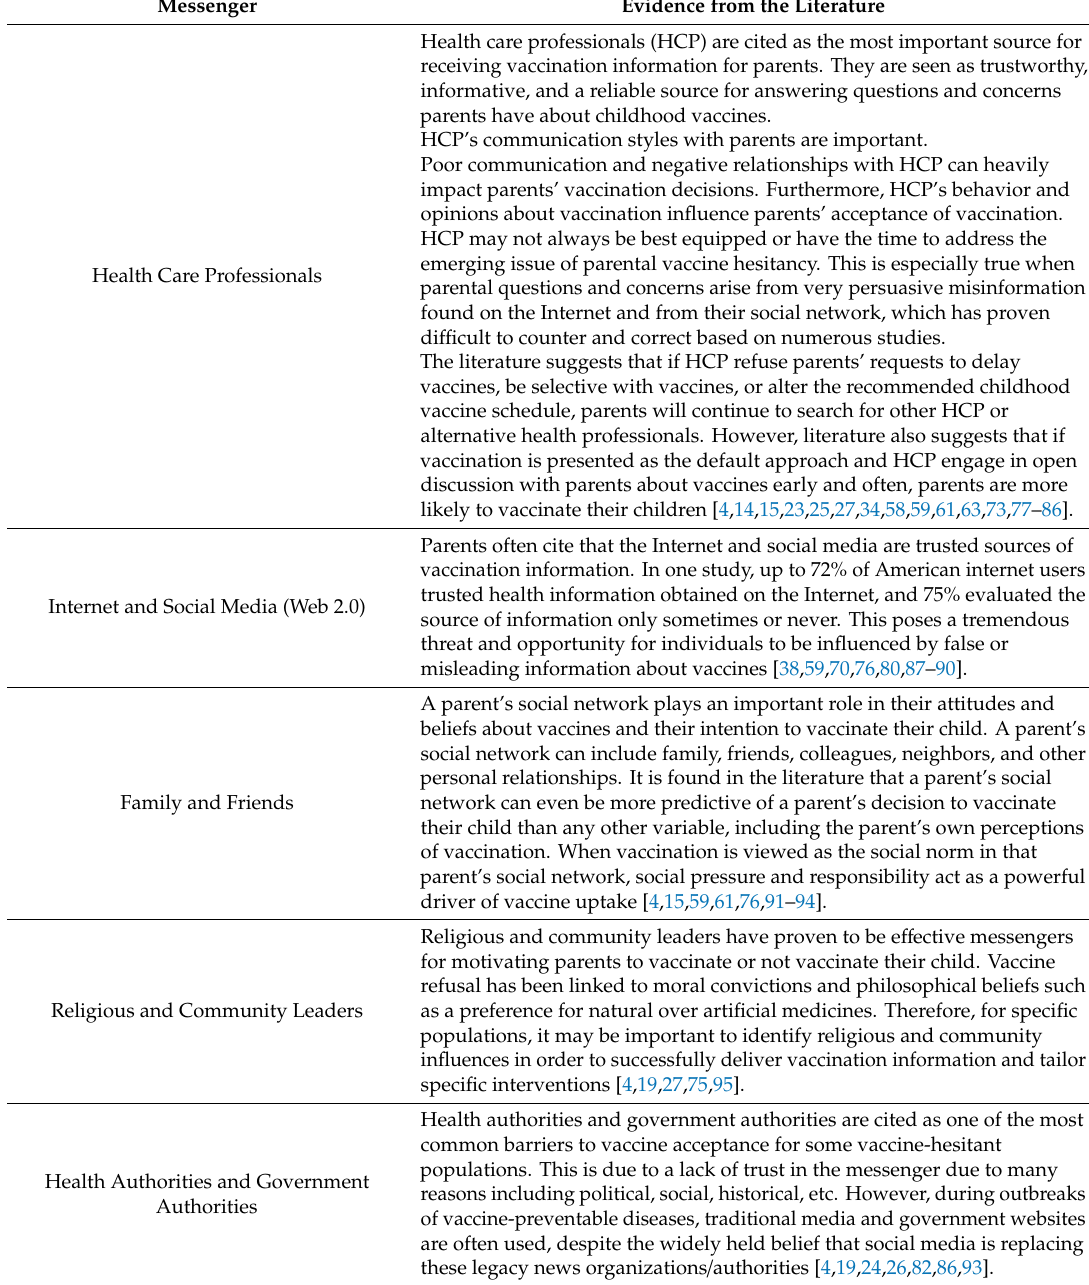
Table 5. Messengers of vaccination